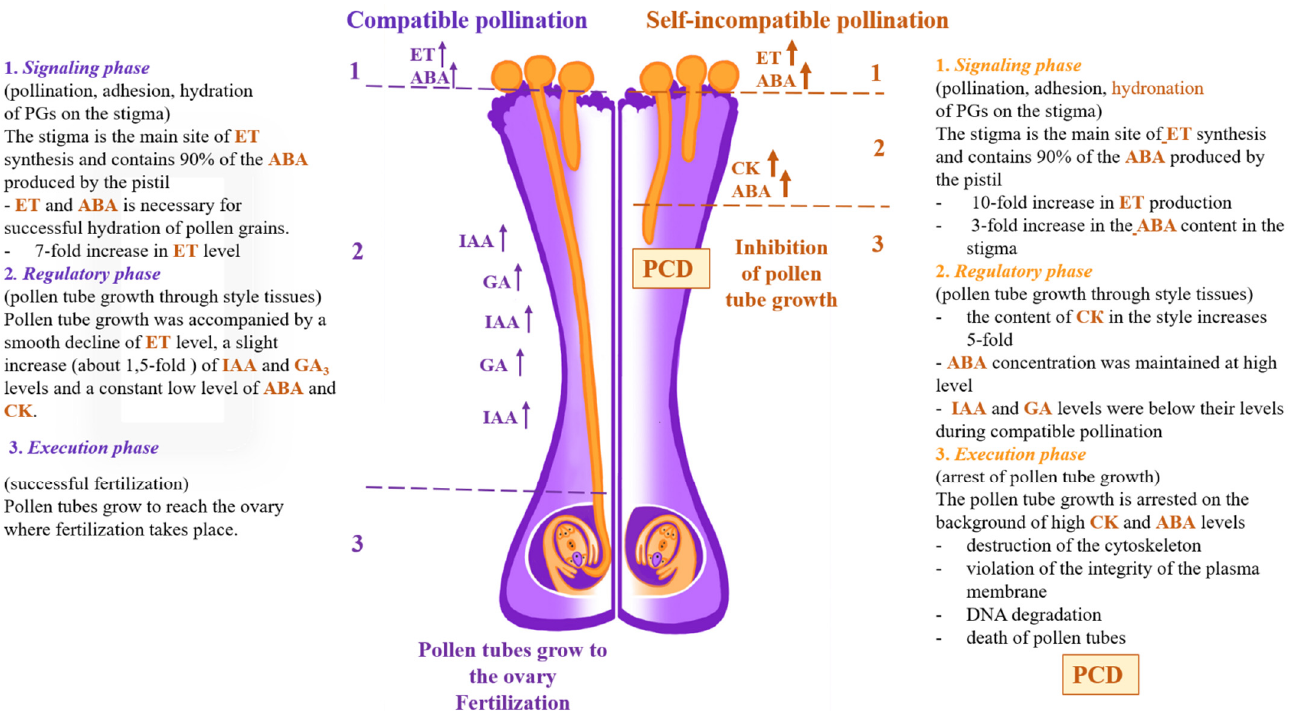
Figure 2. The germination and growth of petunia PT in the compatible and self-incompatible polli- nations and the role of phytohormones at different stages of these processes (scheme). pollinations and the role of phytohormones at different stages of these processes